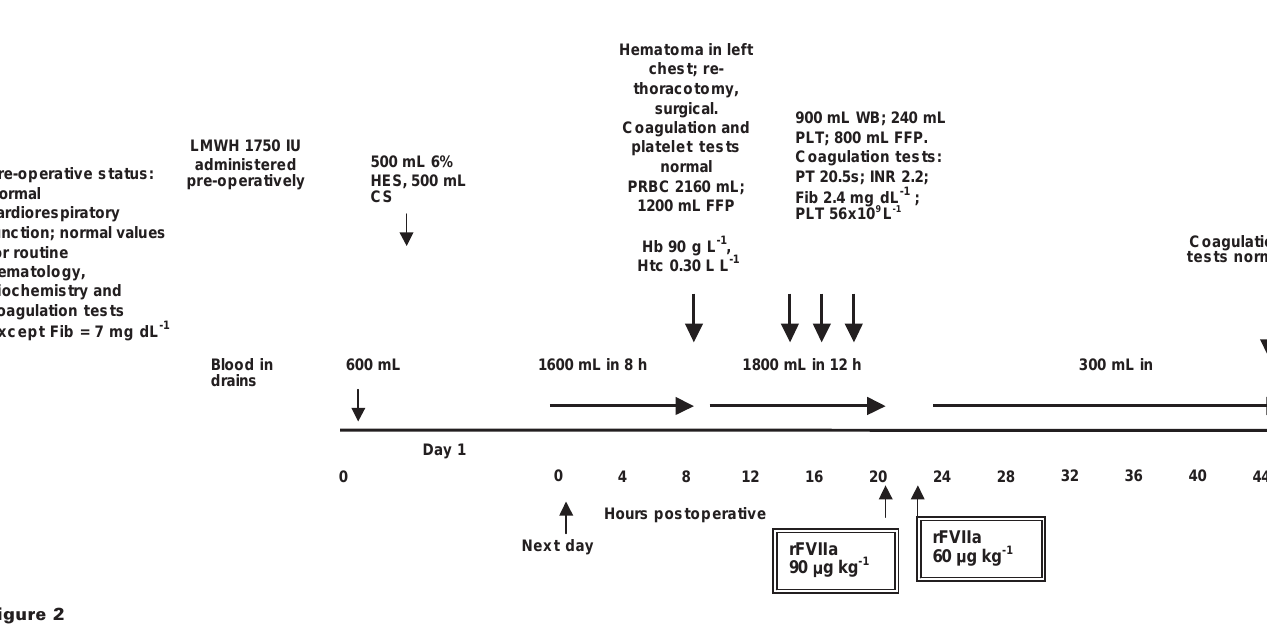
Case 3 – Course of treatment following admission. CS, crystalloid solution; FFP, fresh frozen plasma; Fib, fibrinogen; Hb, haemoglobin; Htc, haematocrit; HES, hydroxyethyl starch; INR, international normalised ratio; LMWH, low-molecular weight heparin; PRBC, packed red blood cells; PLT, platelet concentrates; PT, prothrombin time; rFVIIa, recombinant factor VIIa; Time 0 = end of surgery; WB, whole